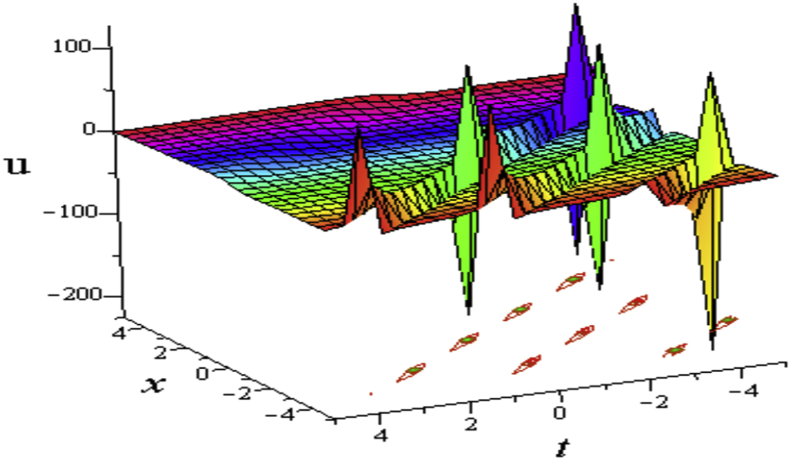
Profile of the Eq. (21) for ℓ1=ℓ2=0,℘1=℘2=0,σ1=σ2=σ3=σ4=1,σ=1,η=0.3,δ=1:3D plot (upper) and contour plot (below) at t = 0.